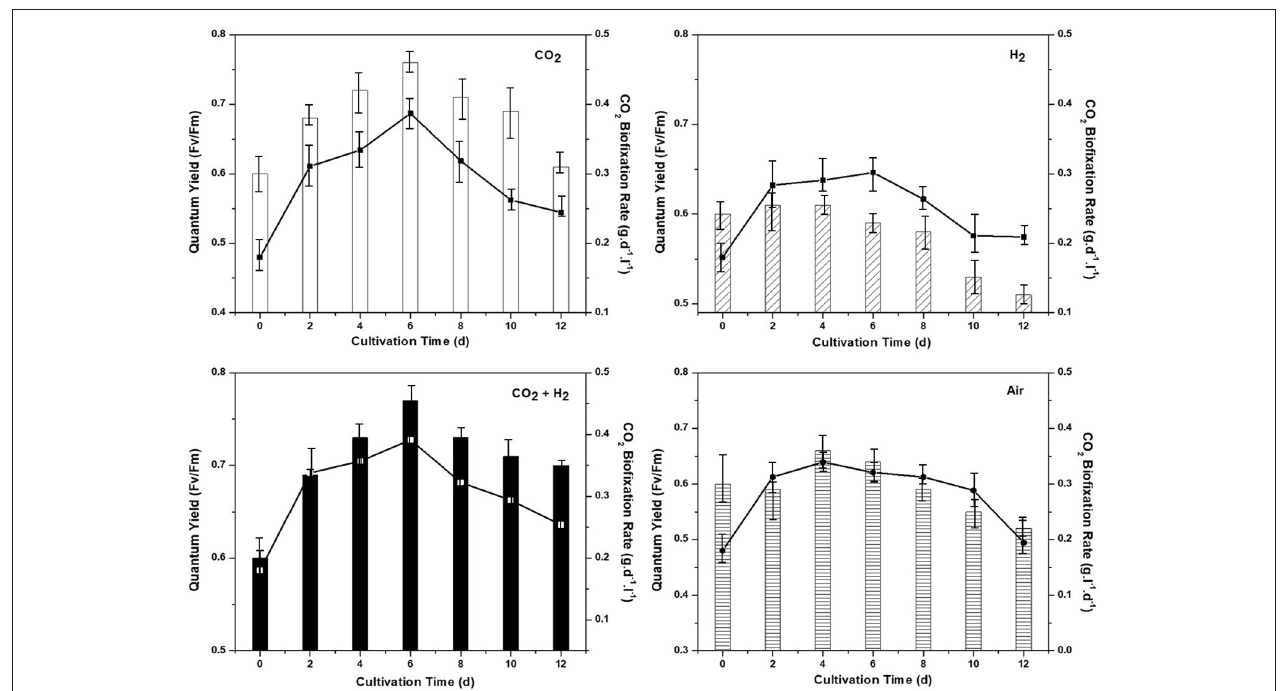
FIGURE 2 | Quantum yield (Fv/Fm) of the dark adapted samples along with the chronological CO 2 biofixation rate (g.l − 1 .d − 1 ) for all the experimental conditions AI, CC, HY, and CH represent clockwise from top